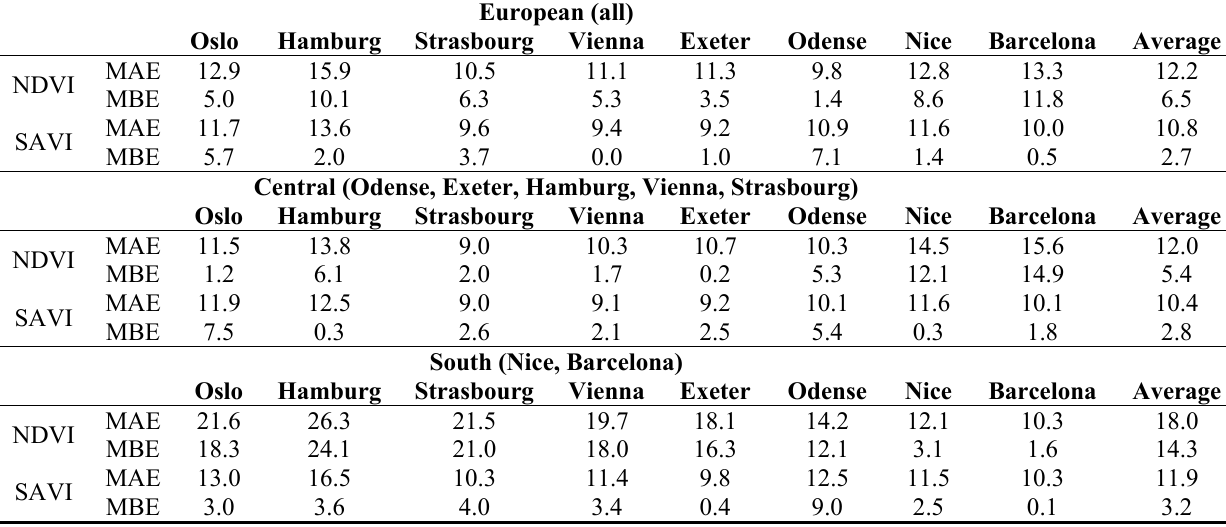
Table A2. MAE’s and absolute MBE’s for IS fraction based on NDVI/SAVI as compared to reference IS fractions for the second order polynomial regression models, European = sub- areas from all cities are included in the regression model, Central = sub-areas from Odense, Hamburg, Strasbourg, Exeter and Vienna are included in the regression model, Southern = Sub-areas from Barcelona and Nice are included in the regression